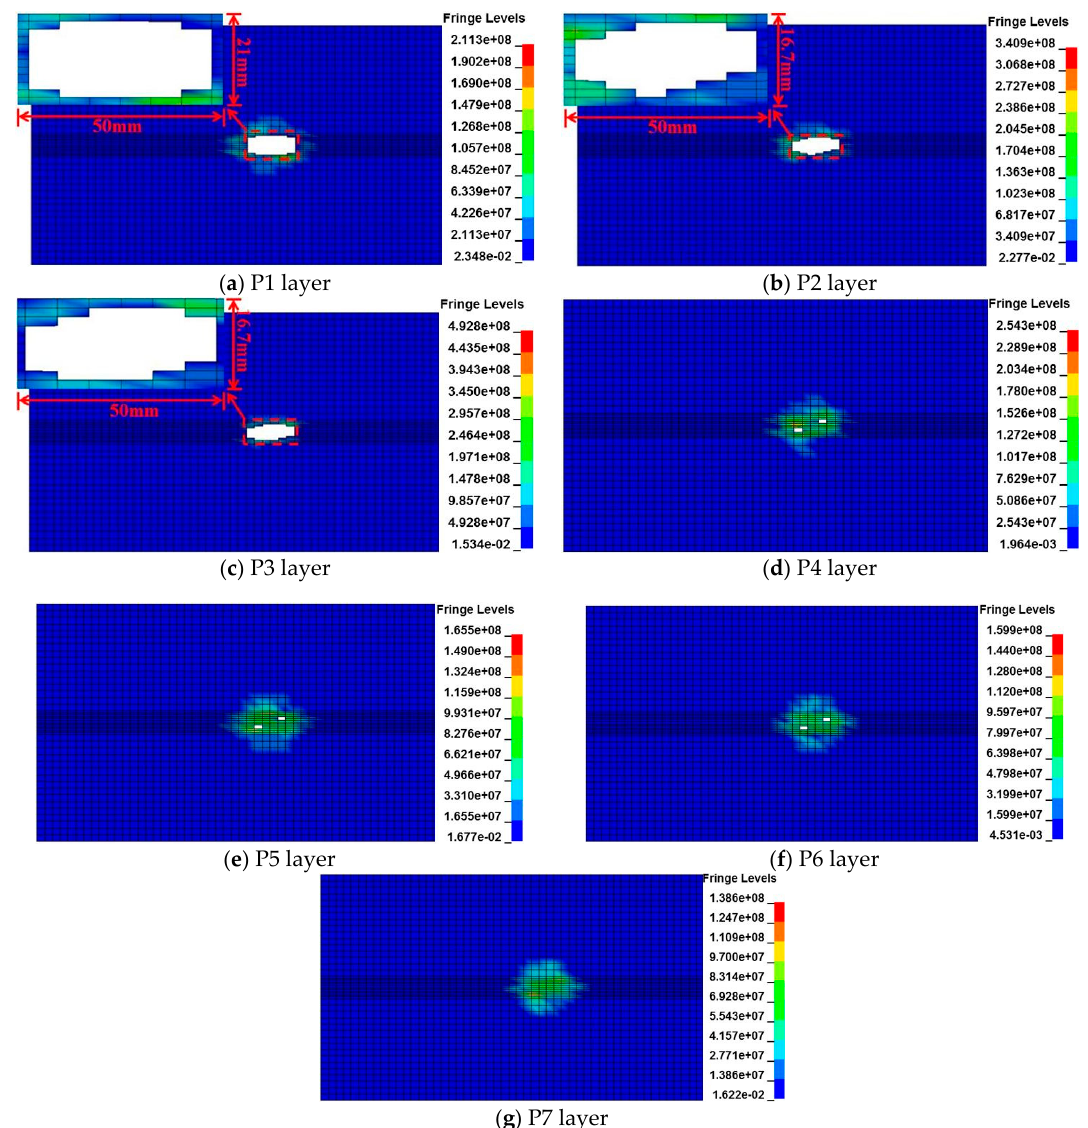
Figure 10. Contours of von Mises stress on the top seven layers of the benchmark skin.